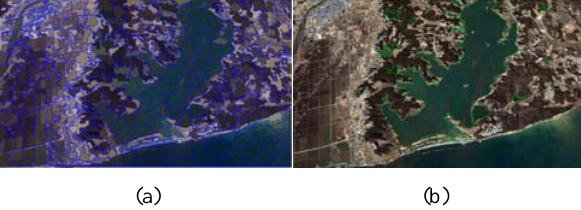
Figure.7 Extraction of Submerged Area in Figure.5 with Change Detection Technology, (a) The result of before-post images segmentation, (b) The result of stagnant water area